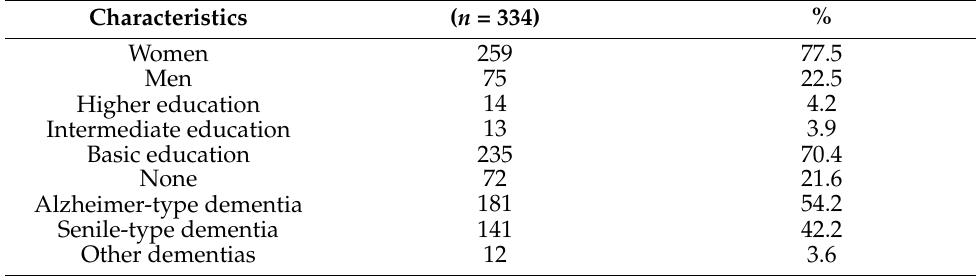
Table 1. Description of